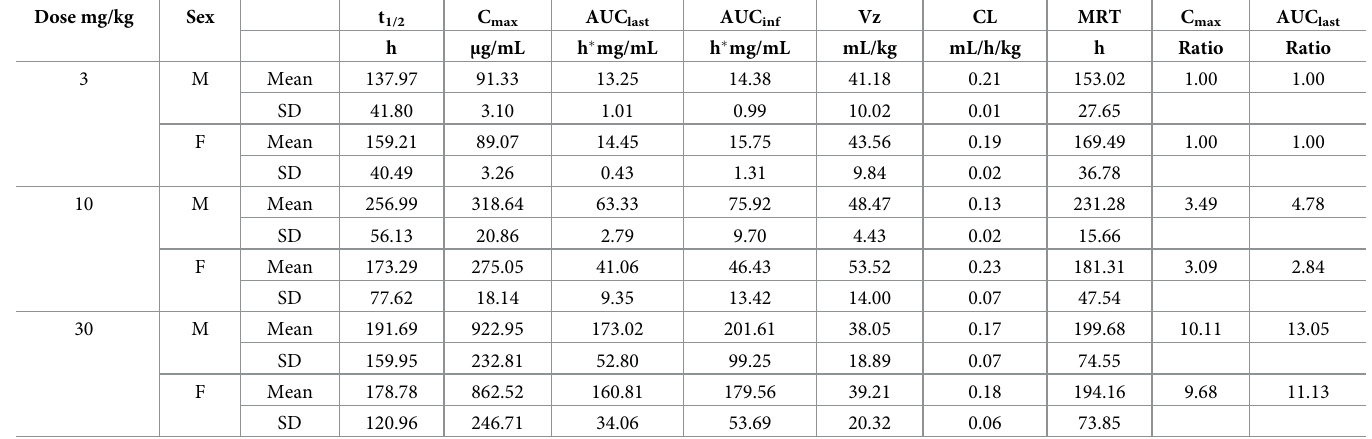
Note: C max ratio and AUC last ratio are relative to the 3 mg/kg dose group